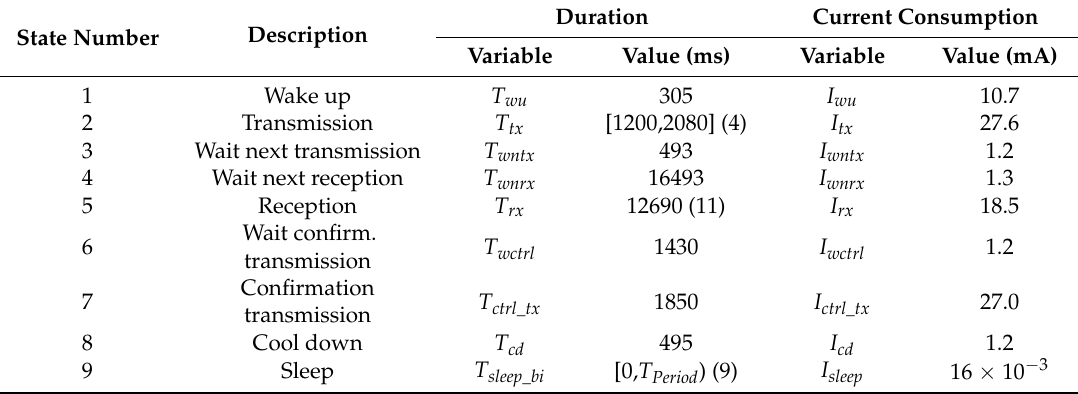
Table 3. States, variables and their values for Sigfox bidirectional transaction. For a bit rate of 100 bit/s, T tx can take values between 1200 ms (1-byte payload) and 2080 ms (12-byte payload). The reception duration ranges from 387 ms up to T DL_WIN_MAX = 25 s (in US and EU regions), with an average of T rx = 12.69 s. T sleep_bi ranges in this study from 0 up to ~ T Period ( T sleep_bi tends to T Period for very high T Period